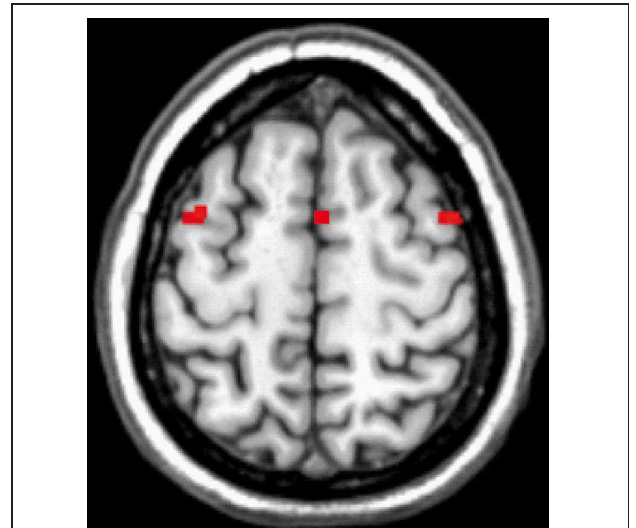
FIGURE 1 | Jointly recruited brain regions following a conjunction analysis between imagined and executed sub-maximum contractions of the elbow flexors ( p < 0 . 00001 FWE corrected). The recruited brain regions were in pre-motor cortex: x , y , z = 44, 4, 58, k = 19, T = 7 . 85; − 38, 4, 56, k = 22, T = 7 . 72 and in the supplementary motor cortex (SMA): x , y , z = 8, 10, 64, k = 29, T = 7 . 62. This indicates that imagery and executed sub-maximum contractions of the elbow flexors share common motor regions and thus we are able to address the research question of eccentric vs. concentric maximum contractions using motor imagery. Note: we also performed separate analysis to investigate if there were differences present between imagined and executed contractions. The results from that analysis showed that all regions recruited for the imagined task was present for the executed task. Moreover, for the executed task the T -values were in general stronger as well as the extent of voxels were larger. Also, primary motor cortex was recruited during the execution. These findings are in accordance with previous studies (e.g., Ehrsson et al., 2003).